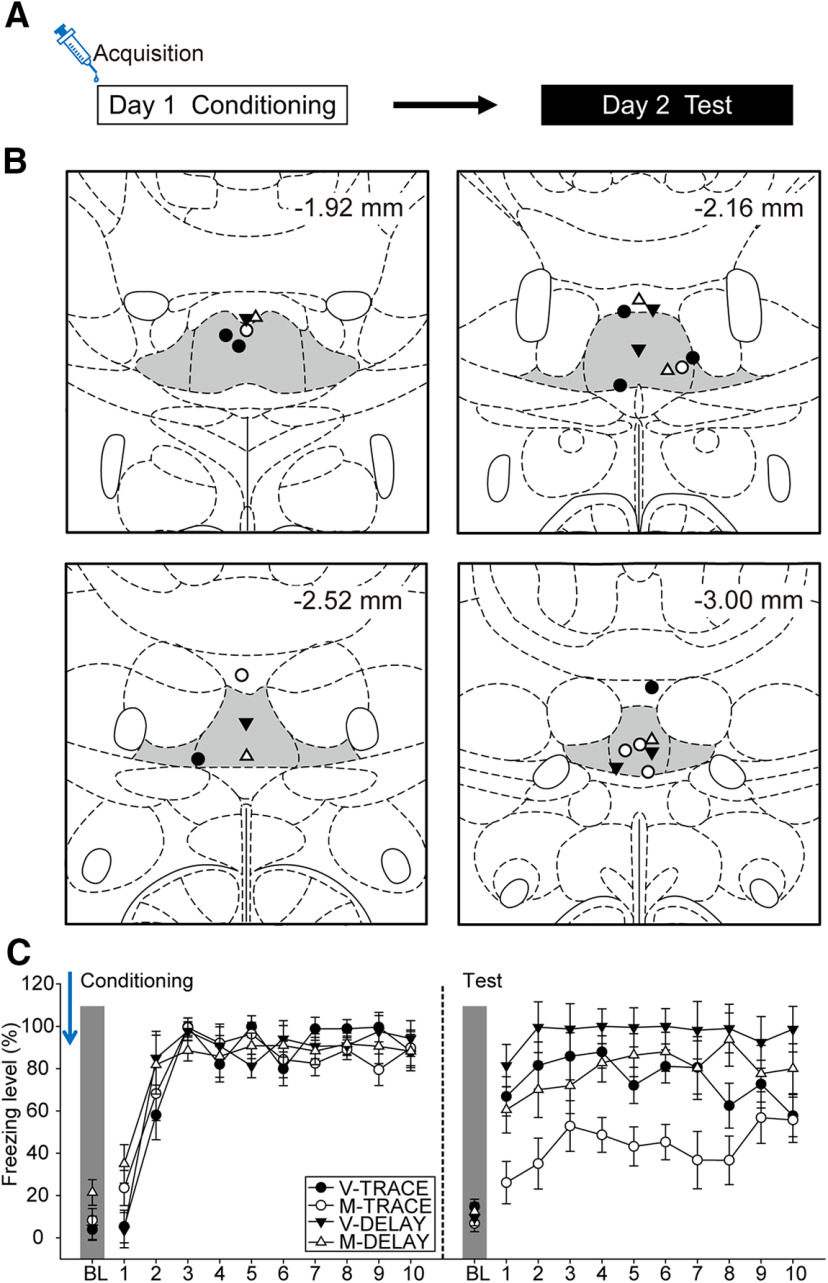
The ReRh was critically involved during the acquisition of trace fear conditioning. A, Experimental design. Animals underwent a 2-d behavioral experiment, in which the animals received drug infusion immediately before conditioning (day 1). B, Injector tip placements of all the animals included in data analyses at levels −1.92, −2.16, −2.52, and −3.00 mm posterior relative to bregma. The gray areas marked in the atlas are the Re and ventral Re. C, The freezing behavior of V-TRACE (n = 7), M-TRACE (n = 6), V-DELAY (n = 6), and M-DELAY groups (n = 5) when injections were performed before conditioning.